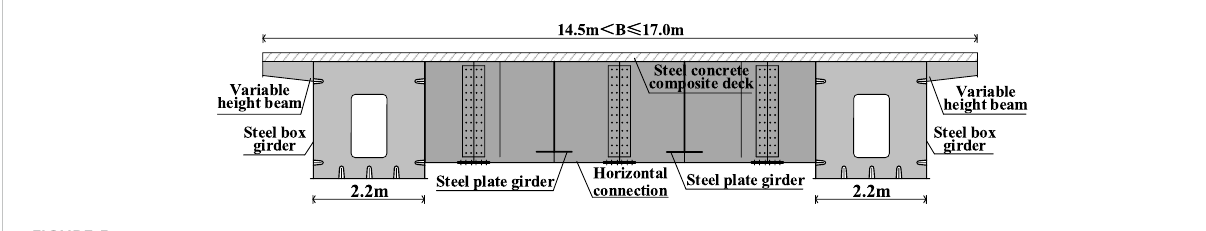
Two I-shaped steel plate girder in the middle of double steel side box girder.